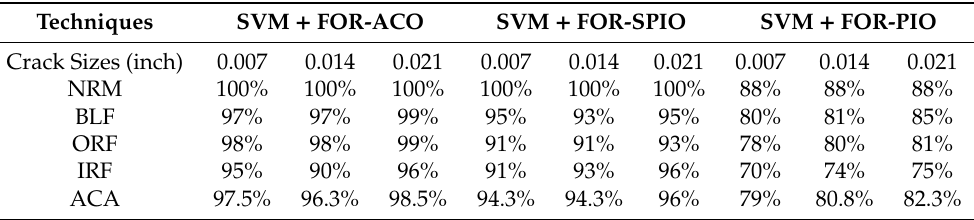
Table 6. The Accuracy of Single-Type Fault Identification When the Torque Load is 1-hp.